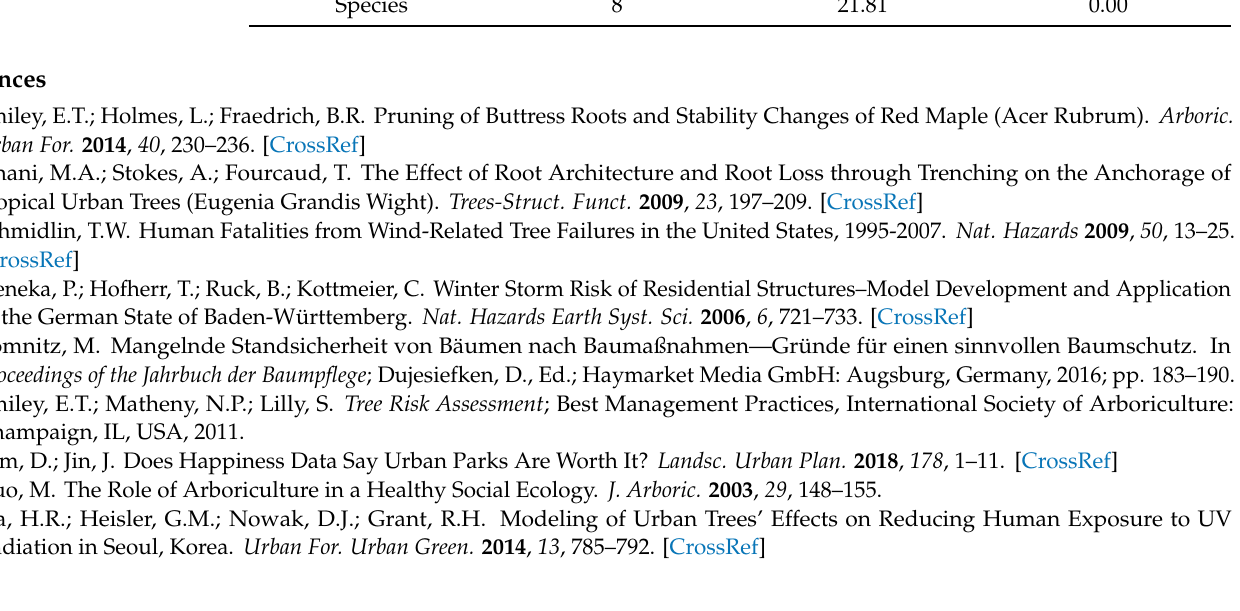
Table A7. ANOVA of model M a